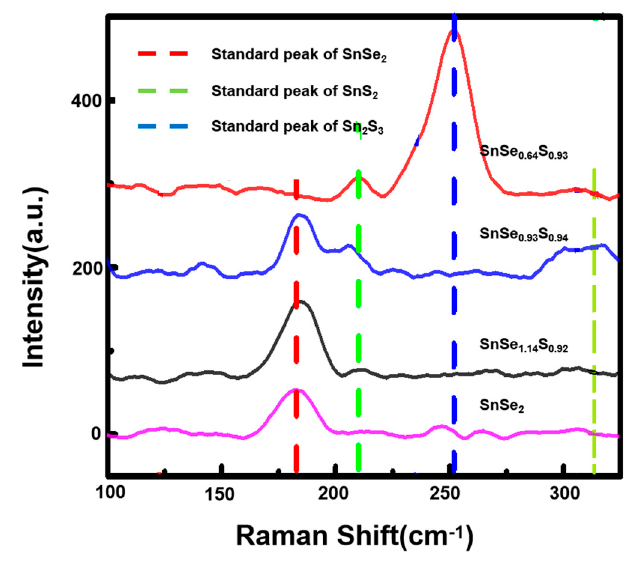
Figure 3. Comparison of Raman spectra of SnSe x S y nanosheets with increasing amounts of S dopant.